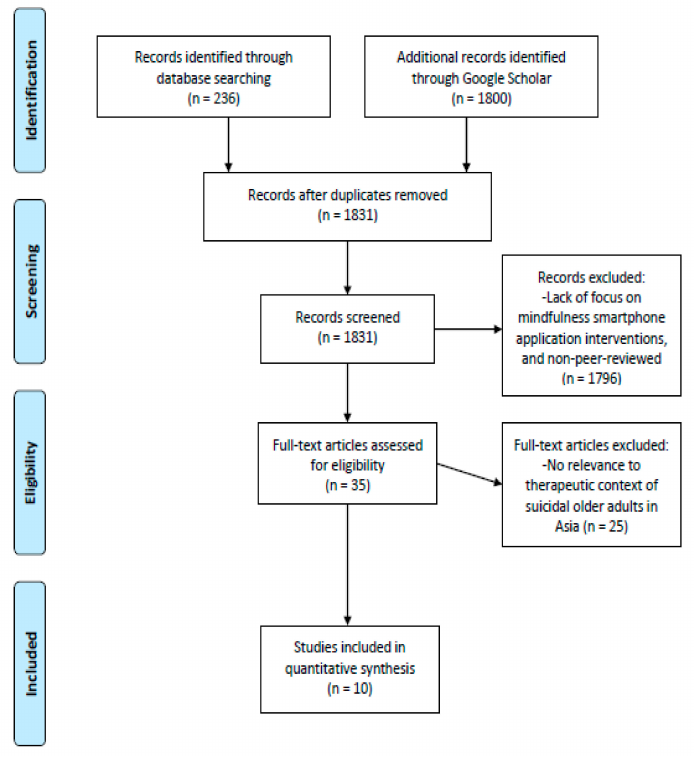
Figure 1. PRISMA flow